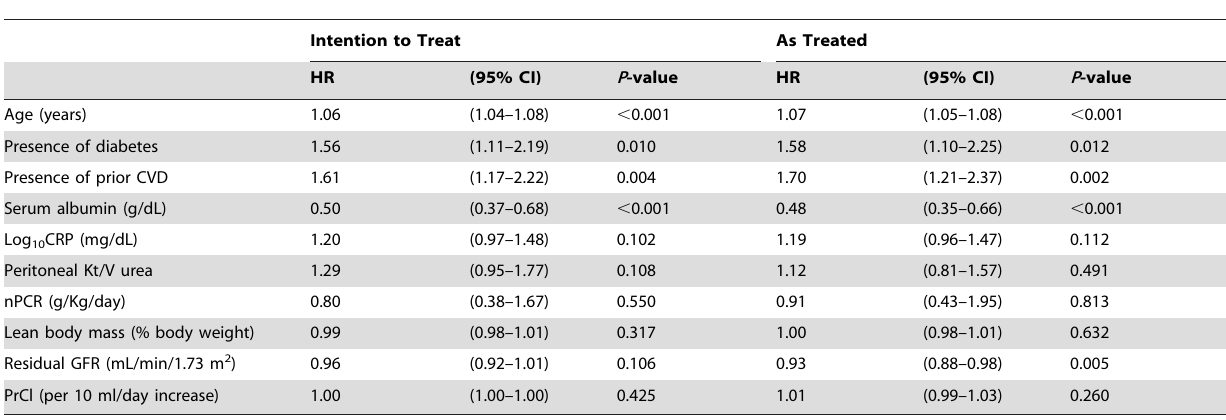
Table 4. Multivariate Cox regression analysis for